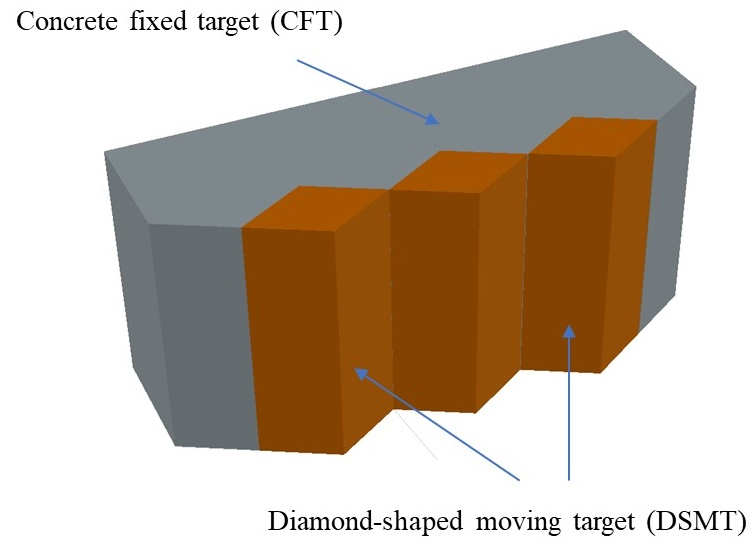
Figure 1. Schematic diagram of composite concrete target plate with diamond-shaped moving targets.